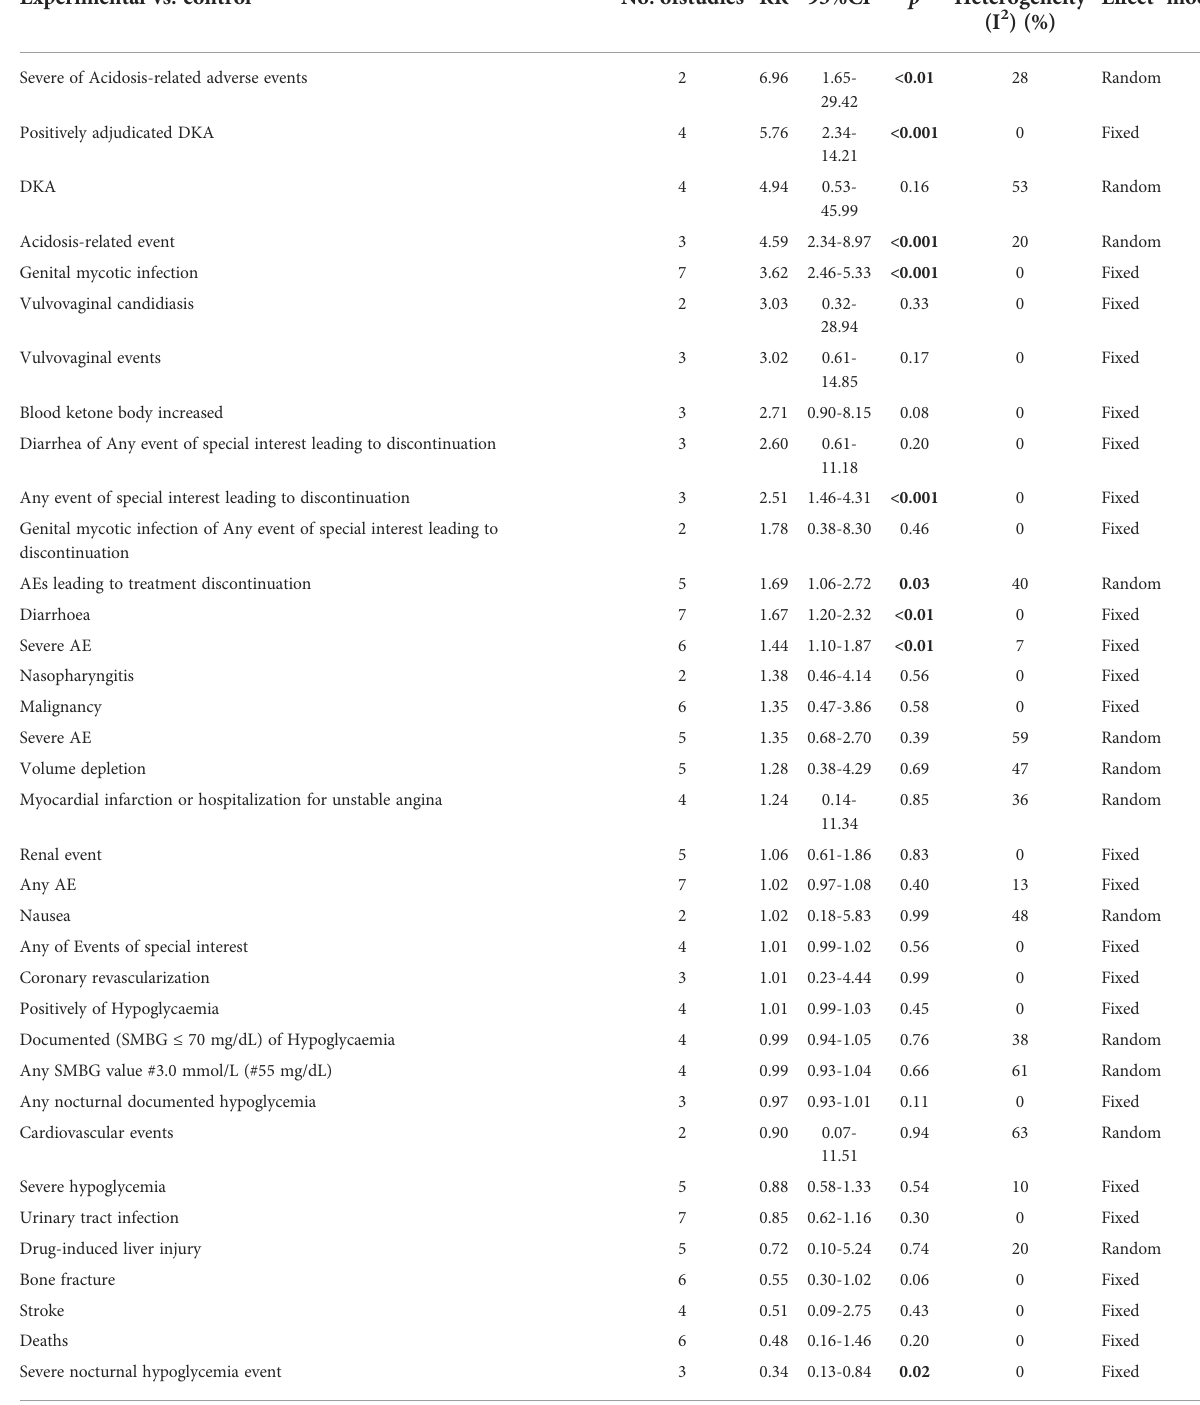
TABLE 2 Subgroup analysis of the adverse events (AEs) in sotagli fl ozin 400mg. Experimental vs.